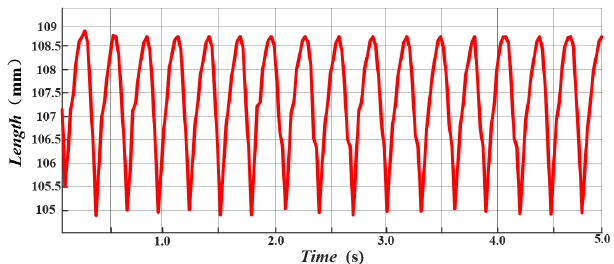
Figure 12. Acceleration of the robot’s centroid along the x direc- tion.